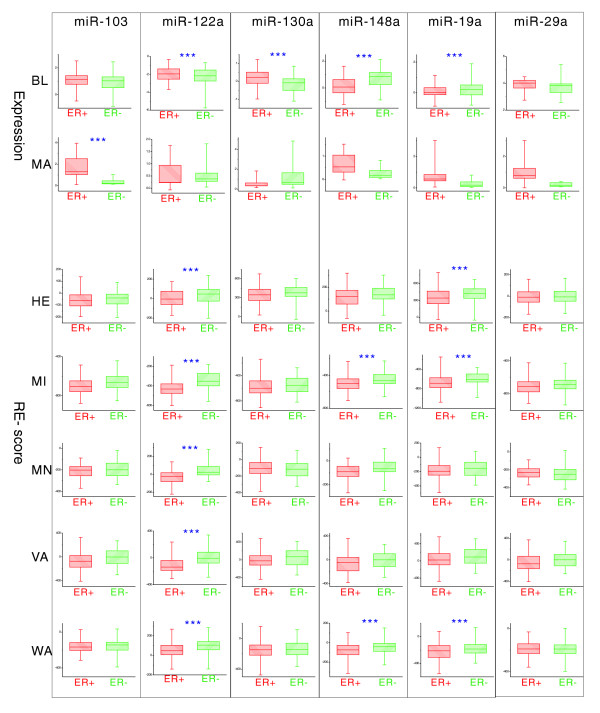
The expressions and RE-scores of microRNAs predicted to target Dicer. BL and MA represent the microRNA microarray data published by Blenkiron et al. [30] and Mattie et al. [32]. HE, MI, MN, VA and WA represent the mRNA microarray data published by Hess et al. [44], Miller et al. [38], Minn et al. [39], van't Veer et al. [34], and Wang et al. [40], which were used to calculate the microRNA RE-scores. If the difference between ER+ and ER- samples is significant, the plot is flagged with three asterixes. The expression levels of these six microRNAs are mostly lower in ER- samples; however, almost all the RE-scores in ER- samples are higher, suggesting that the differential regulatory effects of miRNAs can not be explained by miRNA expression difference between ER+ and ER- cancers.